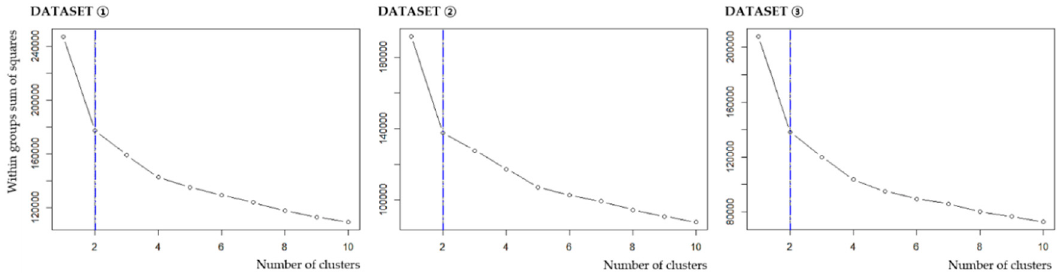
Figure 2. SSE changes with increasing number of clusters.